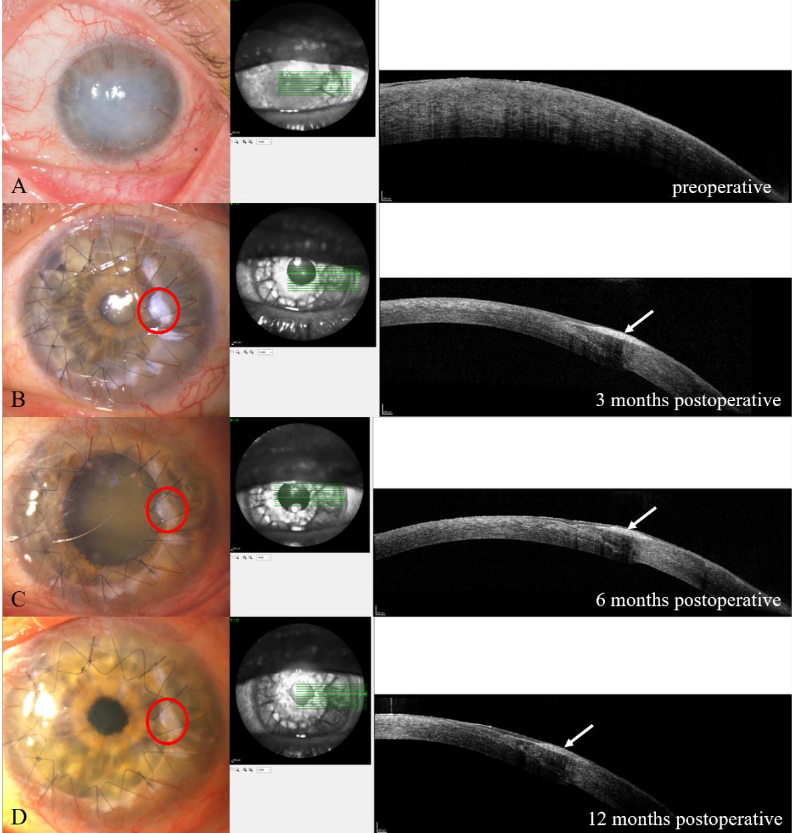
Figure 3. Clinical pictures of a patient with LSCD caused by ocular burn and the results of the AS- OCT. ( A ) = preoperative; ( B ) = 3 months postoperative; ( C ) = 6 months postoperative; ( D ) = 12 months postoperative; arrow = ALT in AS-OCT; red circle = ALT-transplant.